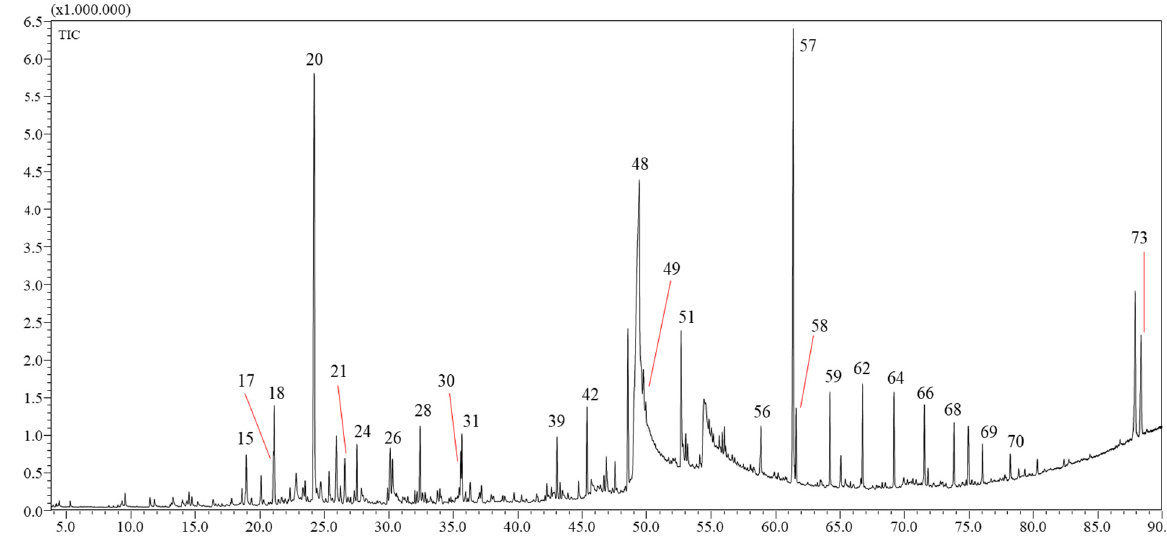
Figure 1. GC-MS profile of the hexane fraction (VF1) of C. althaeoides L. roots.